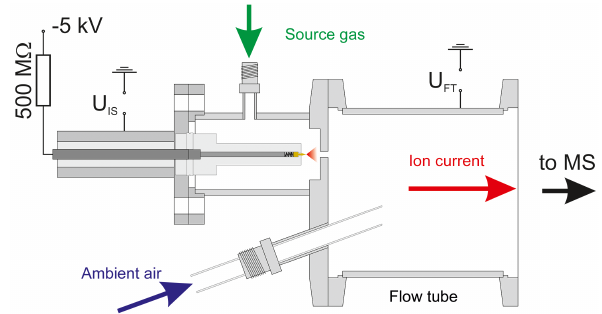
Figure 2. The gas discharge ion source for AIMS-TG: the electri- cal setup is identical to the AIMS-H 2 O source except for the high voltage potential which is negative and generally lower in absolute measures. In this assembly, the source gas SCF 8 is ionized in the region between the needle tip and an aperture plate. Afterwards the source gas carrying the reagent ions is mixed with ambient air in the flow tube where trace gases react with SF − to form product 5 ions. To enhance mixing between trace gases and reagent ions, the sample flow with ambient air is directed into the ion